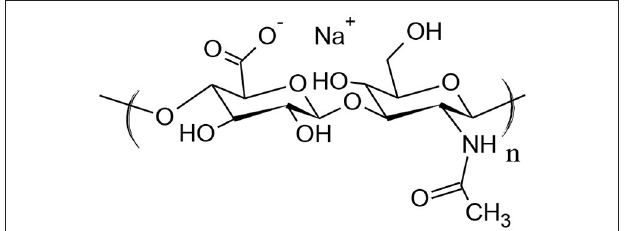
FIGURE 1 | Structure of hyaluronan